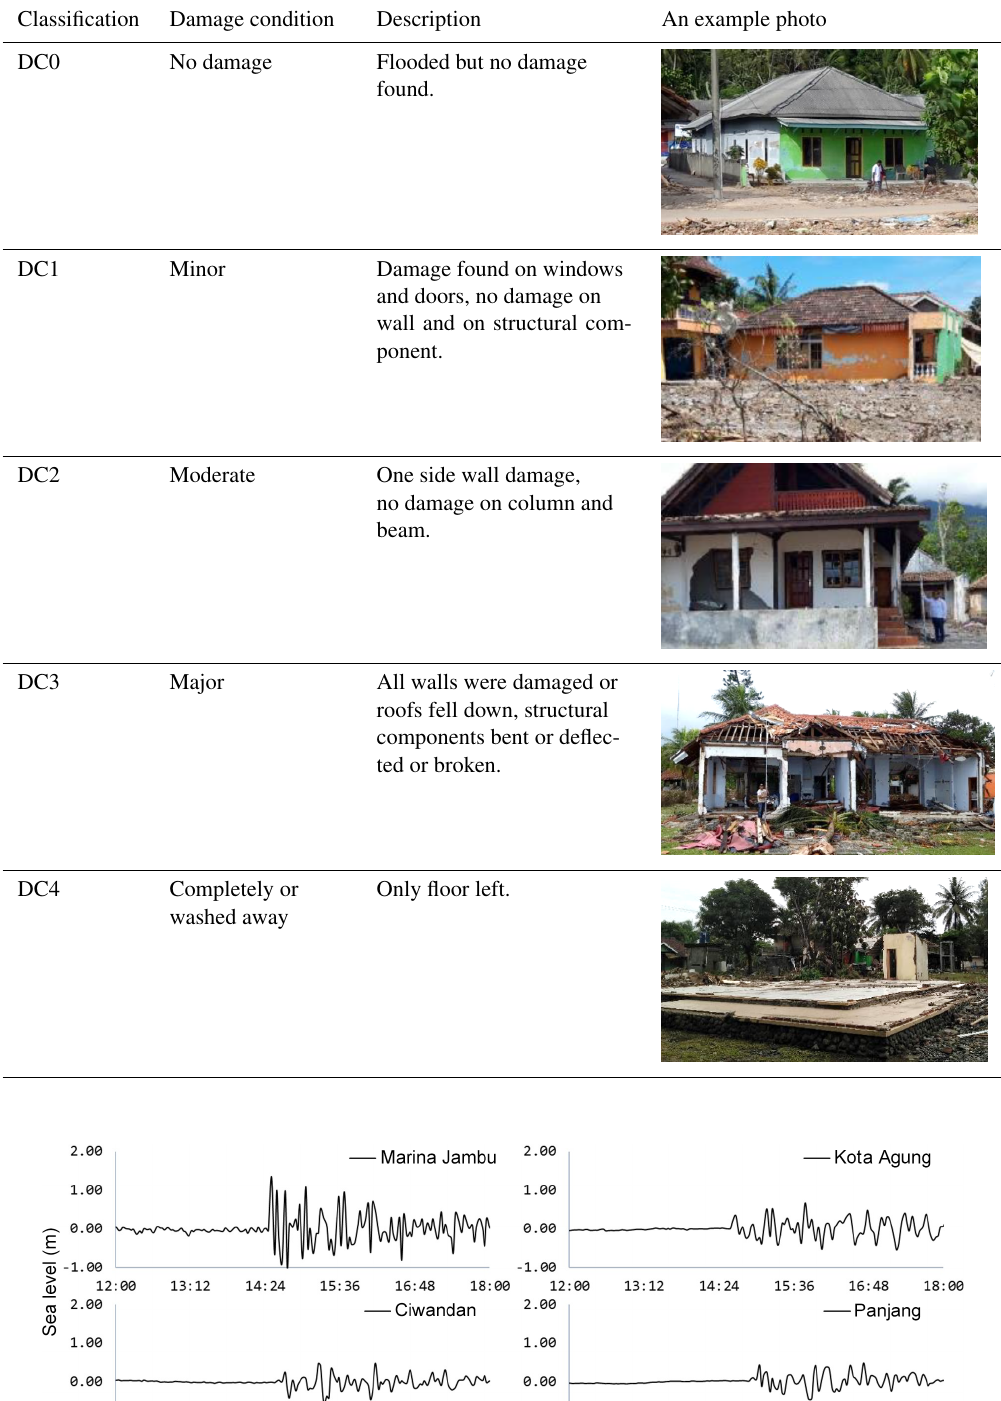
Table 1. Damage states of buildings due to tsunami as suggested by Suppasri et al. (2011) and Macabuag et al. (2016).